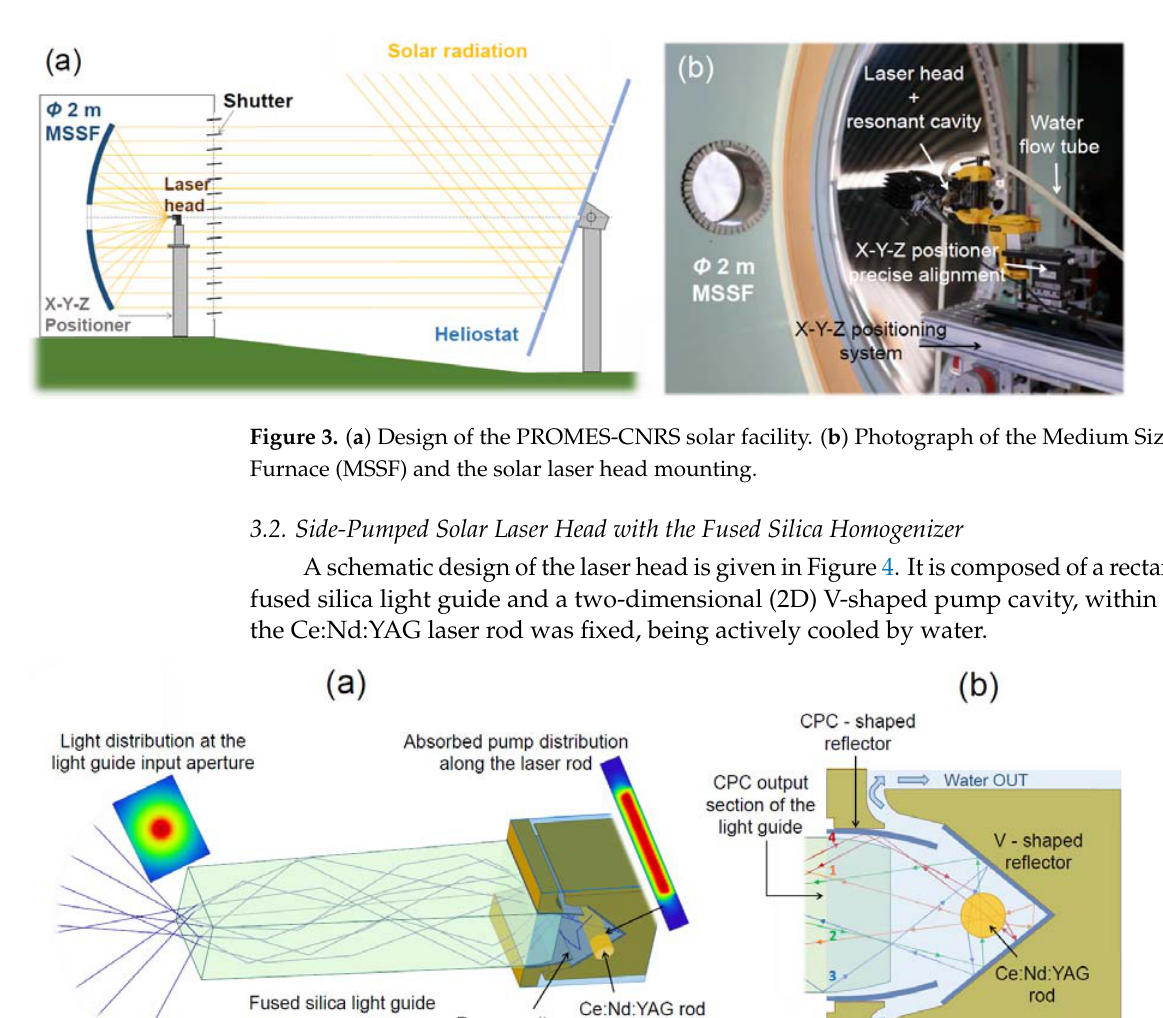
Figure 3. ( a ) Design of the PROMES ‐ CNRS solar facility. ( b ) Photograph of the Medium Size Solar Furnace (MSSF) and the solar laser head mounting.